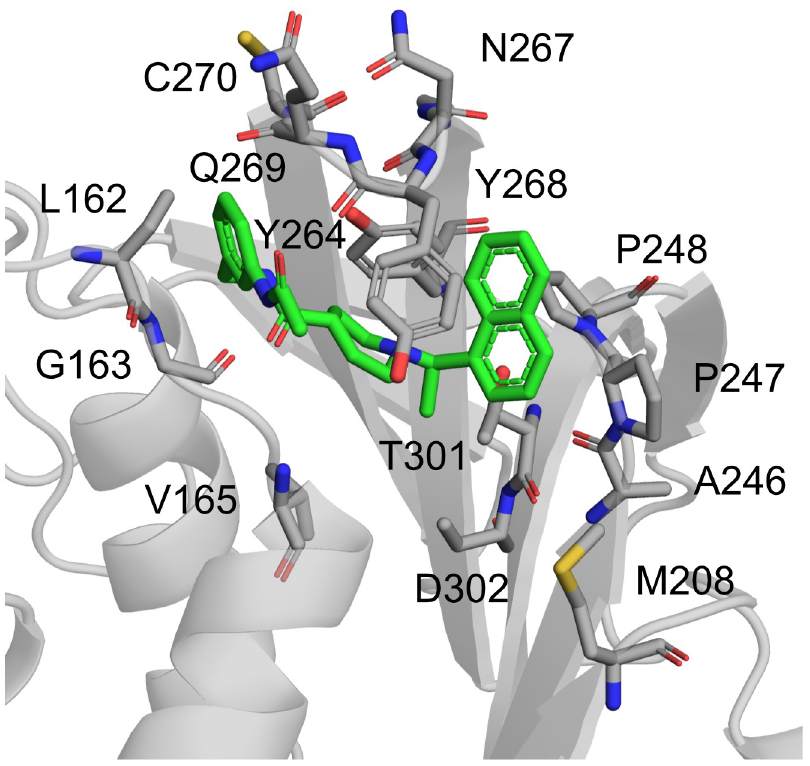
Fig 2. Structure of PLpro and variants within noncovalent inhibitor binding site. The rates of mutations of these residues are presented in Table 1, along with the residues they are replaced to. It is worth noting that the residues forming the BL2 also can be mutated (aa 267–270). Based on PLpro-S43 complex from PDB ID: